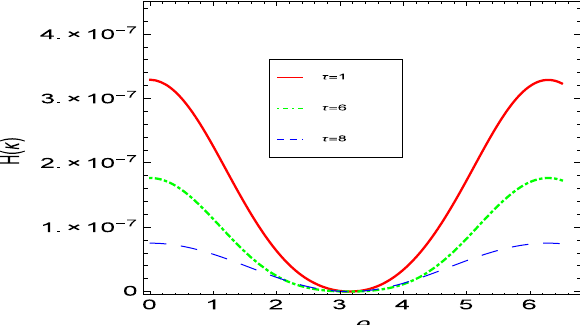
Fig. 5 QFIintheestimationofthedeformationparameterasafunction of the initial state parameter θ with fixed effective time τ . The effective deformation parameter is fixed as κ = 1000, the velocity of detector is given by v = 0 . 9994 and the effective centripetal acceleration is a = 0 . 2. The different effective time τ = 1 , 6 , 8, respectively